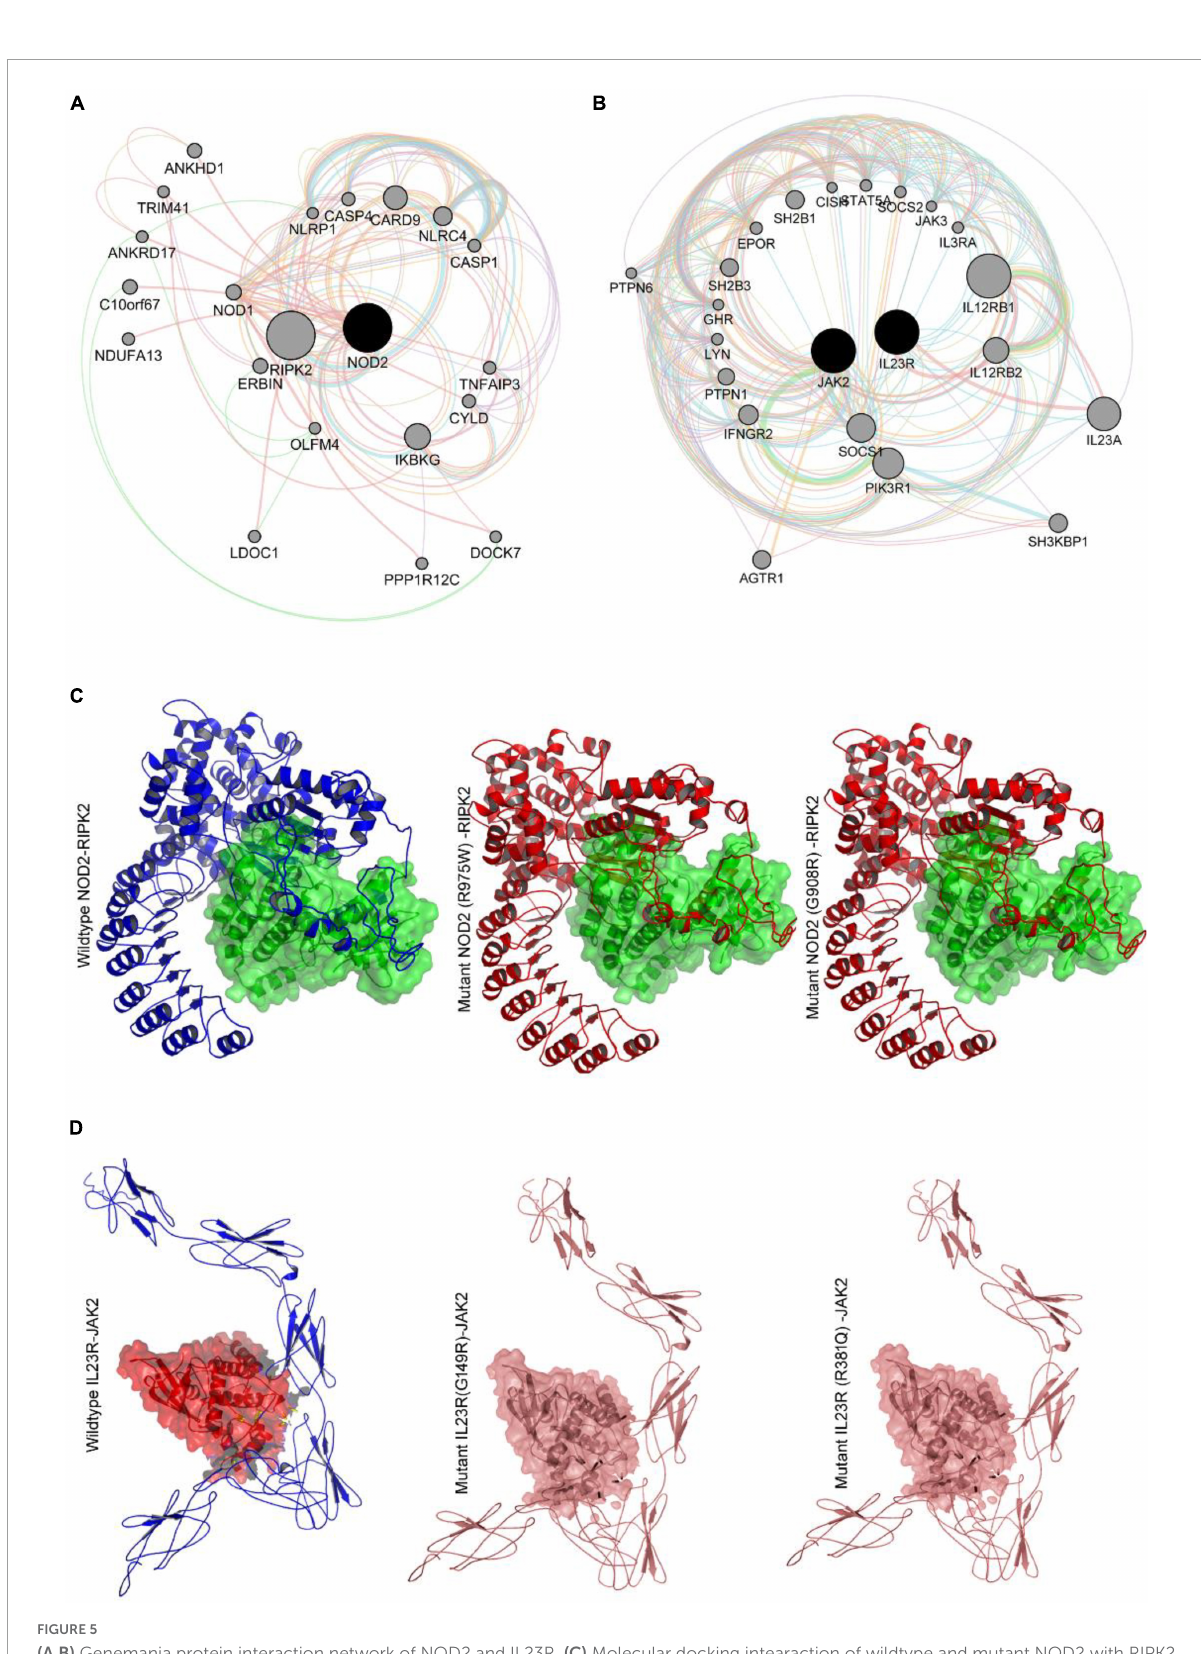
FIGURE5 (A,B) Genemania protein interaction network of NOD2 and IL23R. (C) Molecular docking intearaction of wildtype and mutant NOD2 with RIPK2. (D) Molecular docking interaction of wildytype and mutant IL23R with